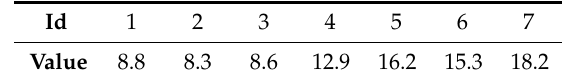
Table 6. The interpolation results of SOF2.